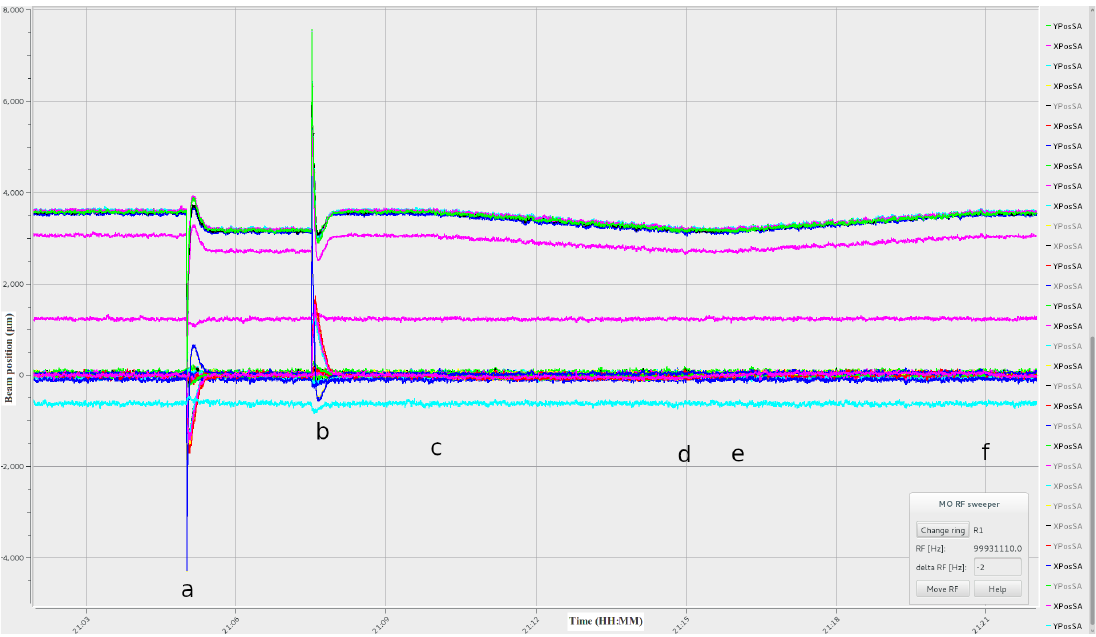
Figure 13. The soft Master Oscillator RF in use. The vertical axis displays the beam position (in µ m) for several BPMs (represented by various colors), while the vertical axis displays the time (in HH:MM format). The MO RF is increased directly by 5 Hz at the marked point “a” and decreased by the same amount at point “b”. An increase by 5 Hz is than performed between points “c” and “d”, followed by a 5 Hz decrease between points “e” and “f”. The tool’s graphical user interface (GUI) can be seen in the bottom-right corner.